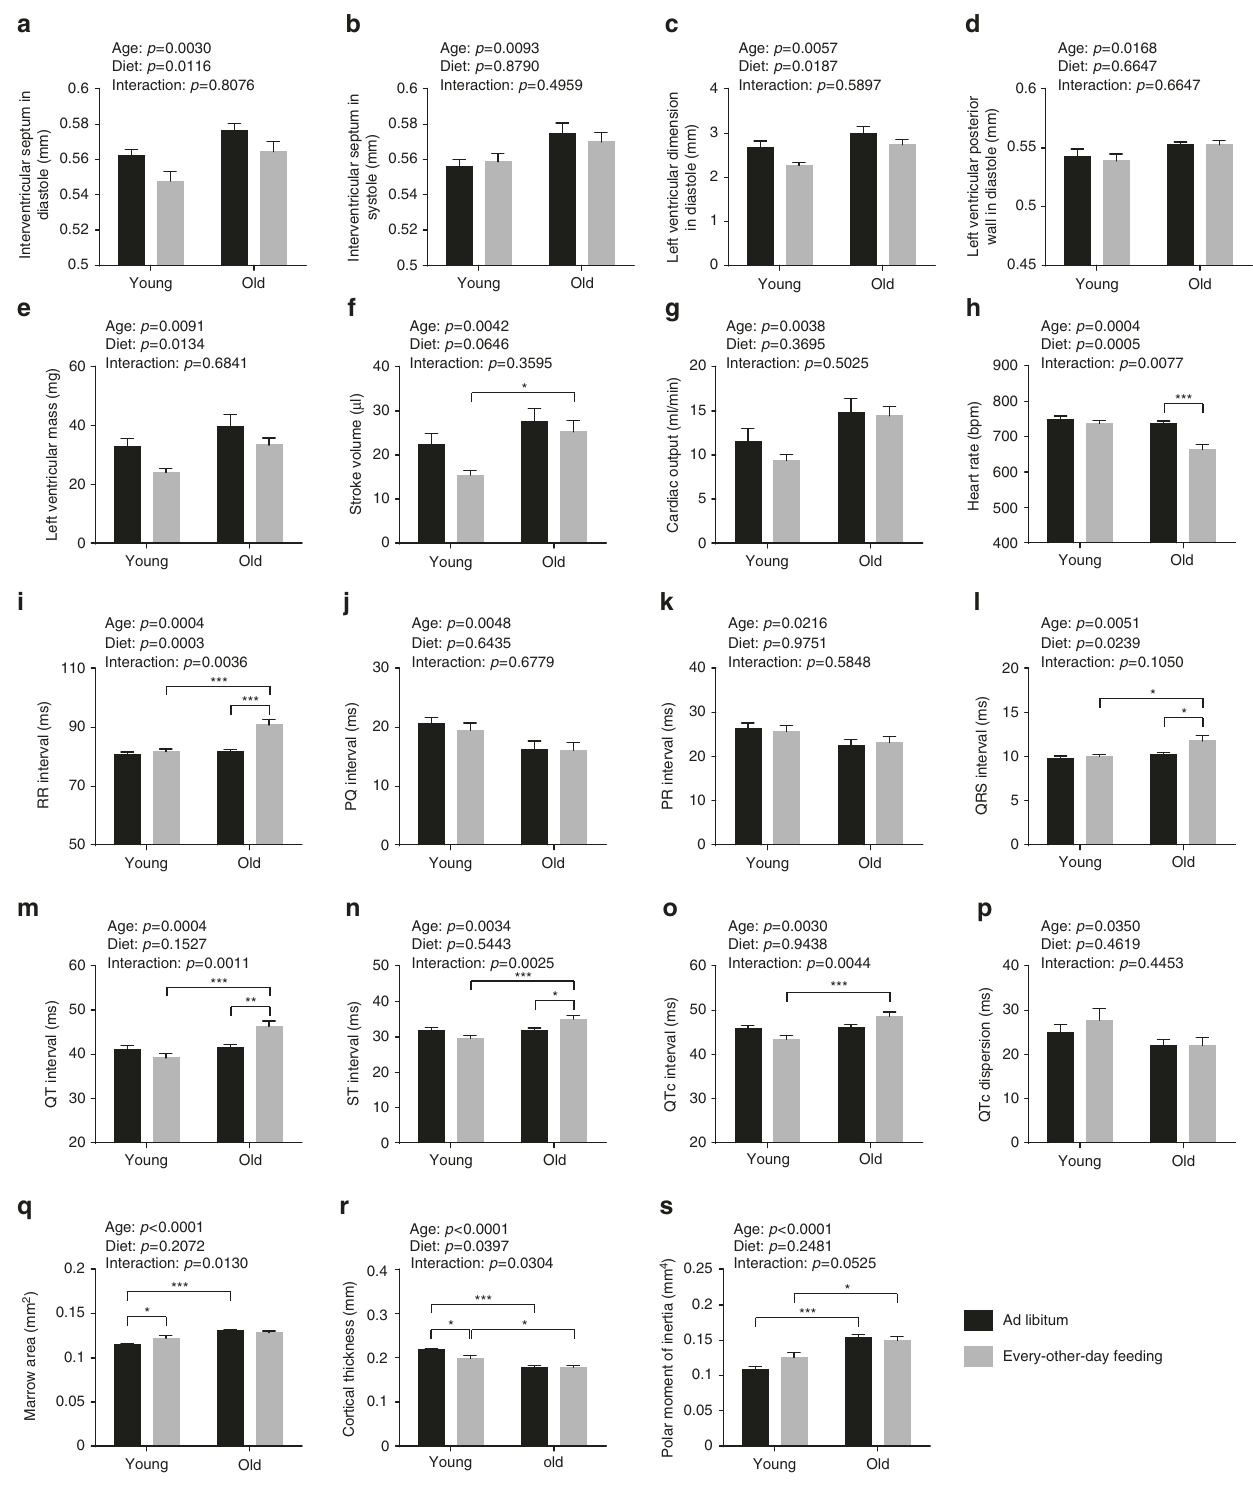
Fig. 3 Cardiological analyses and assessment of bone structure. a – g Ventricular dimensions and functions were examined with transthoracic echocardiography (two-way ANOVA; young + AL: n = 10, young + EOD: n = 9, old + AL: n = 11, old + EOD: n = 11). Dimensions of a interventricular septum in diastole, b interventricular septum in systole, c left ventricle in diastole, and d left ventricular posterior wall in diastole were determined. e Mass of left ventricle, f stroke volume, and g cardiac output were calculated. h – p ECGs were recorded from conscious mice (two-way ANOVA; young + AL: n = 10, young + EOD: n = 9, old + AL: n = 11, old + EOD: n = 11). h HR, i RR interval, j PQ interval, k PR interval, l QRS interval, m QT interval, n ST interval, o QTc interval, p QTc dispersion. q – s Bone architecture was examined using micro-CT of distal tibia (two-way ANOVA; young + AL: n = 16, young + EOD: n = 9, old + AL: n = 17, old + EOD: n = 9). q Marrow area, r cortical thickness, s polar moment of inertia. AL ad libitum, EOD every-other-day feeding. Data are shown as mean ± SEM. Full data sets of echocardiography, electrocardiography, and micro-CT assessments are presented in Supplementary Tables 10 – 12